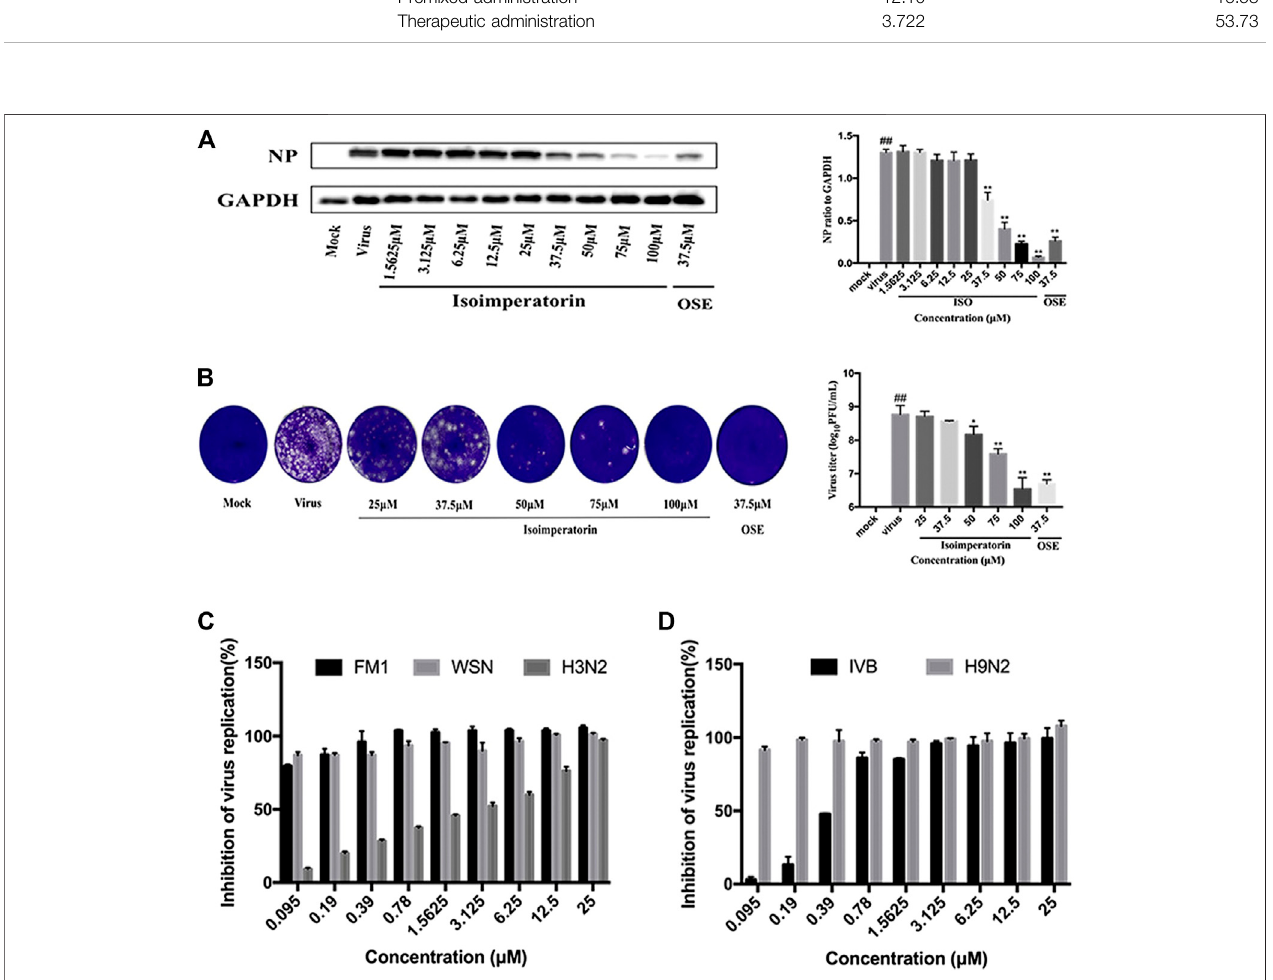
FIGURE 3 | Isoimperatorin inhibits in fl uenza virus infection in vitro . (A) Isoimperatorin inhibited NP protein expression. Oseltamivir served as a positive control. (B) Isoimperatorin reduced the formation of viral plaques. Oseltamivir served as a positive control. (C) Antiviral activity of isoimperatorin against different strains of in fl uenza virus. MDCK cells were infected with different strains of in fl uenza virus, and then the antiviral effects of isoimperatorin were detected by CCK-8 assay. Data are representative of three independent experiments (mean ± SEM). Statistical signi fi cance was analysed by one-way ANOVA. # p < 0.05, ## p < 0.01, relative to the mock control group. *p < 0.05, **p < 0.01, relative to the virus group.